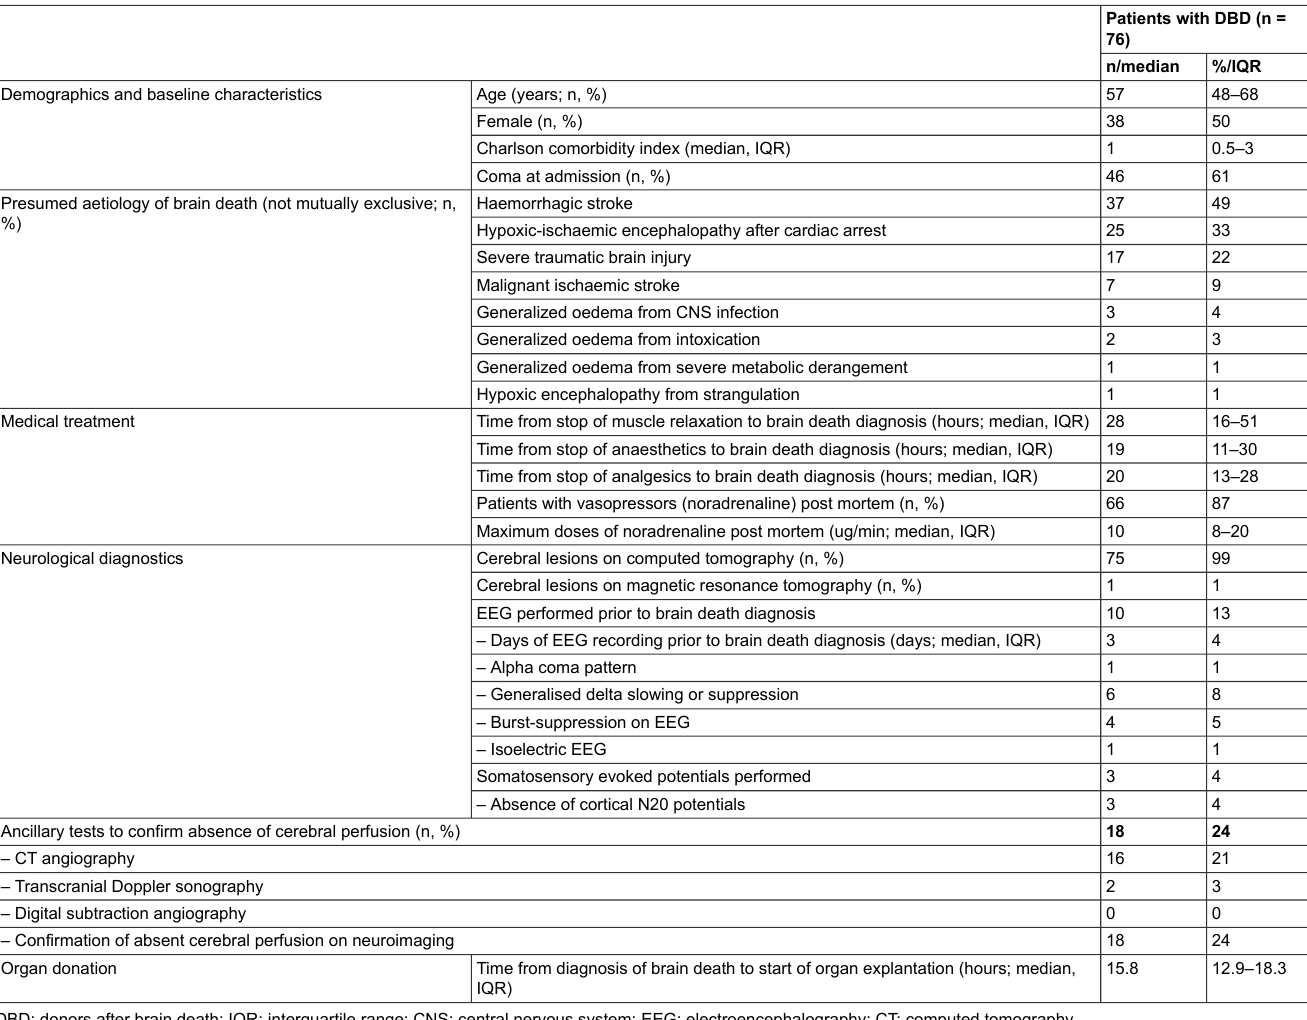
Table 1: Demographics, baseline characteristics, treatment and diagnostic measures of patients who were organ donors after brain death (DBD).